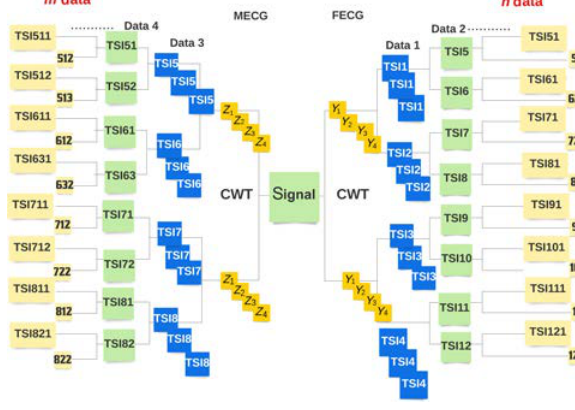
Fig. 10 Submatrix Y ( t ).